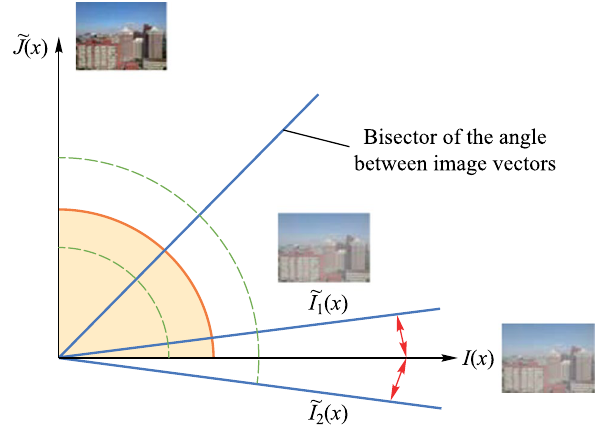
Fig. 4 Cosine similarity between the hazy image and the